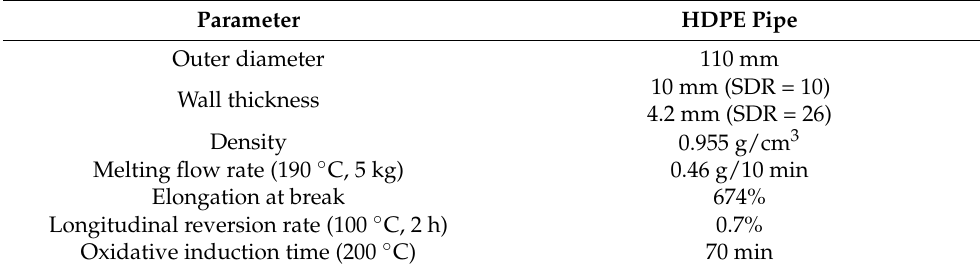
Table 1. Material properties of the HDPE pipe tested in this paper.